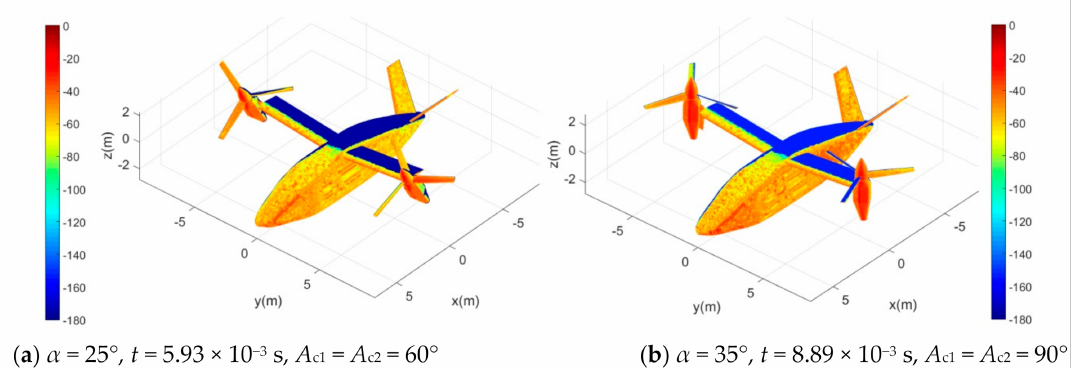
Figure 10. Surface scattering of the aircraft, β = 0 ◦ , f rh = 10 GHz, n r1 = n r2 = 1500 r/min, RCS unit: dBm 2 . ( a ) Surface scattering at α = 25 ◦ , t = 5.93 × 10 − 3 s, A c1 = A c2 = 60 ◦ . ( b ) Surface scattering at α = 35 ◦ , t = 8.89 × 10 − 3 s, A c1 = A c2 = 90 ◦